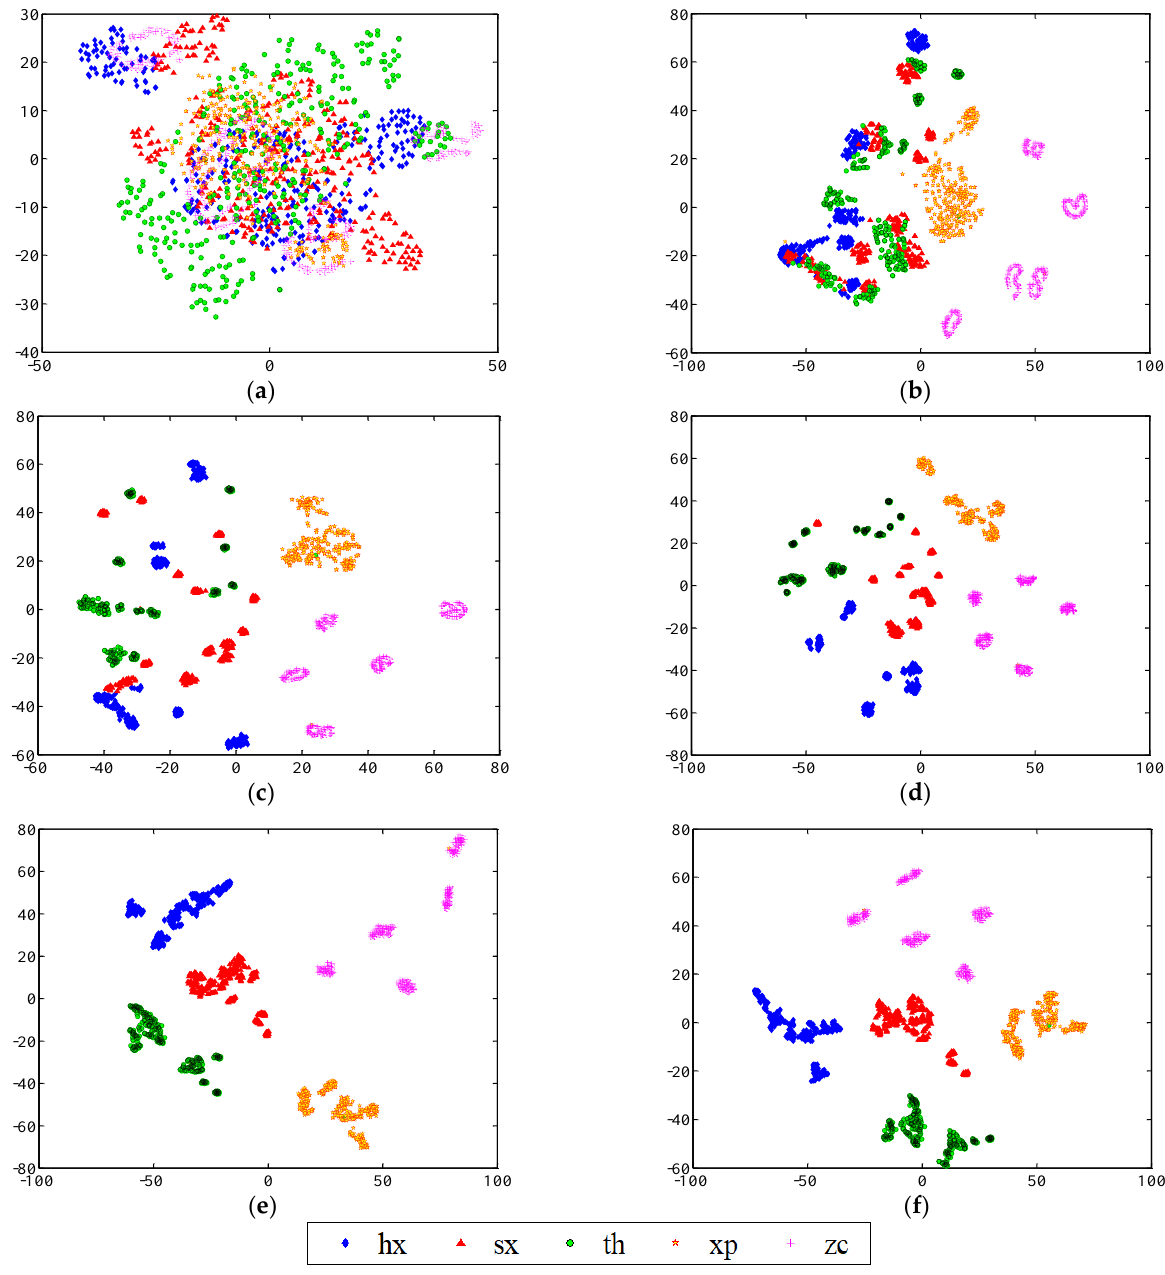
Figure 20. Curves of training and testing accuracy in 10 trials.